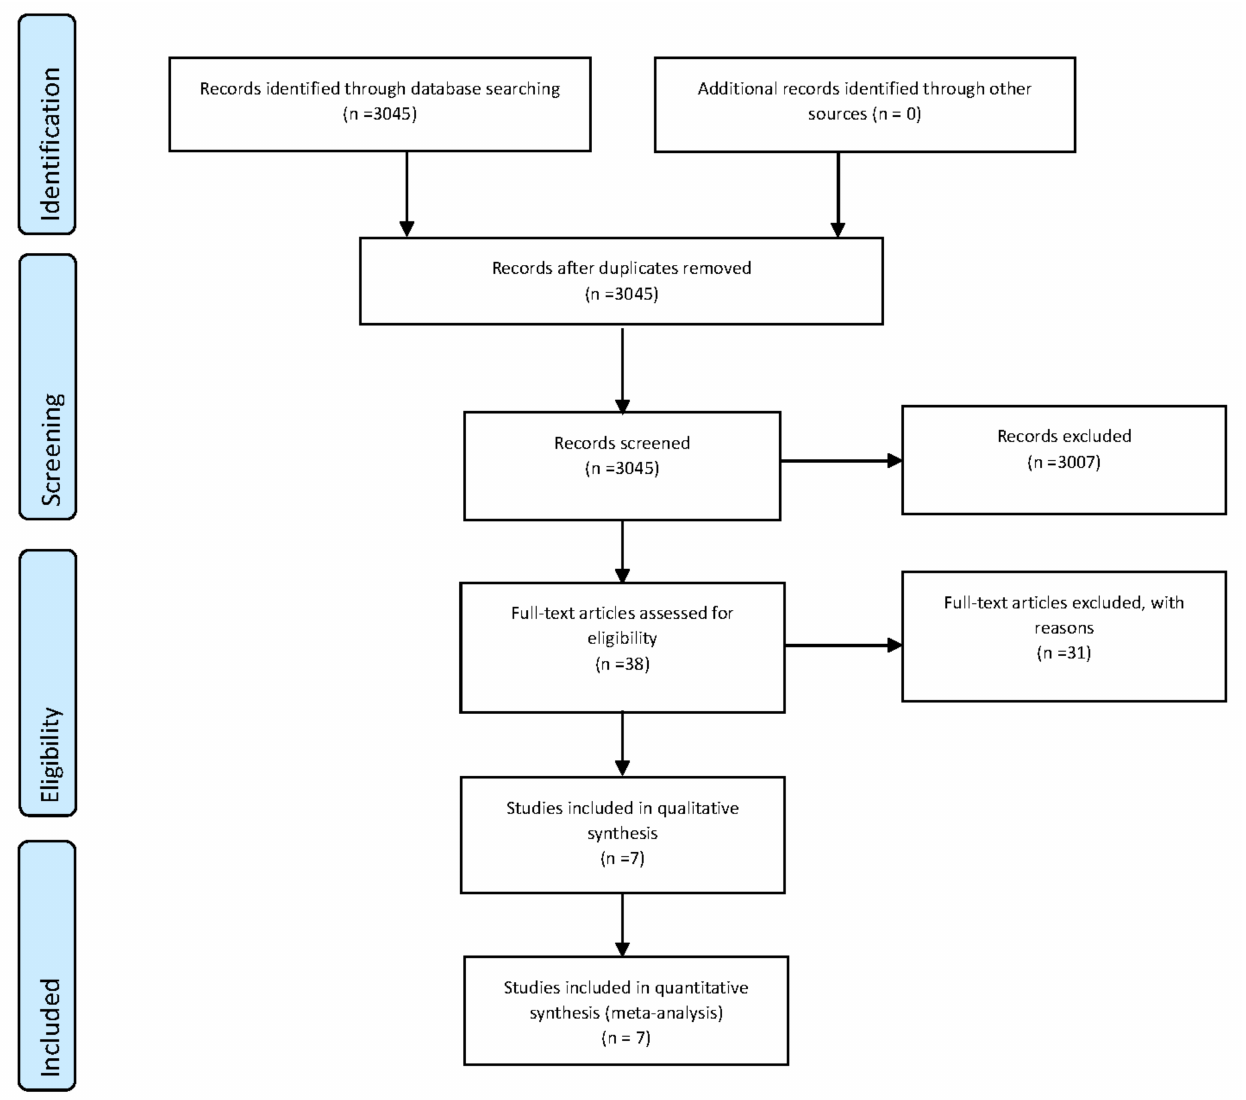
Figure 1. Selection process for the systematic review and